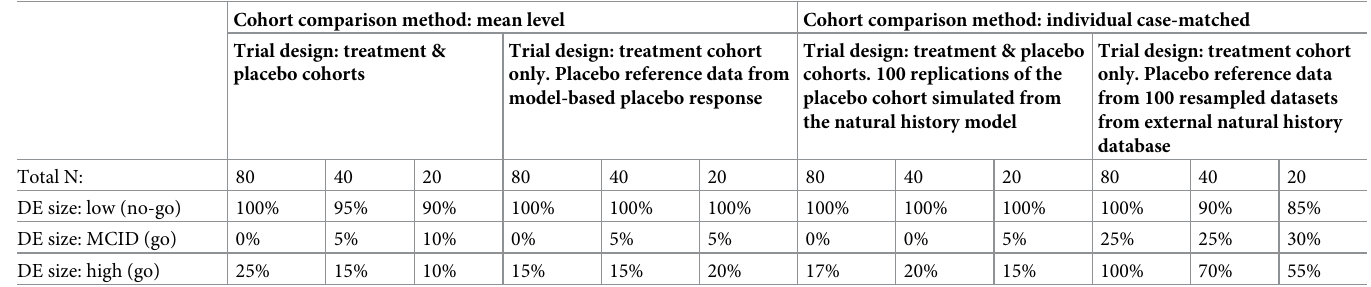
Table 2. Performance of the Bayesian model-based go/no-go decision making methods across trial designs and data analysis methods. Criteria for go/no-go decisions were at least an 80% posterior predictive probability of the CFBCFP � 30 meters at 1 year post-baseline. Cohort comparison method: mean level Cohort comparison method: individual case-matched Trial design: treatment & placebo cohorts